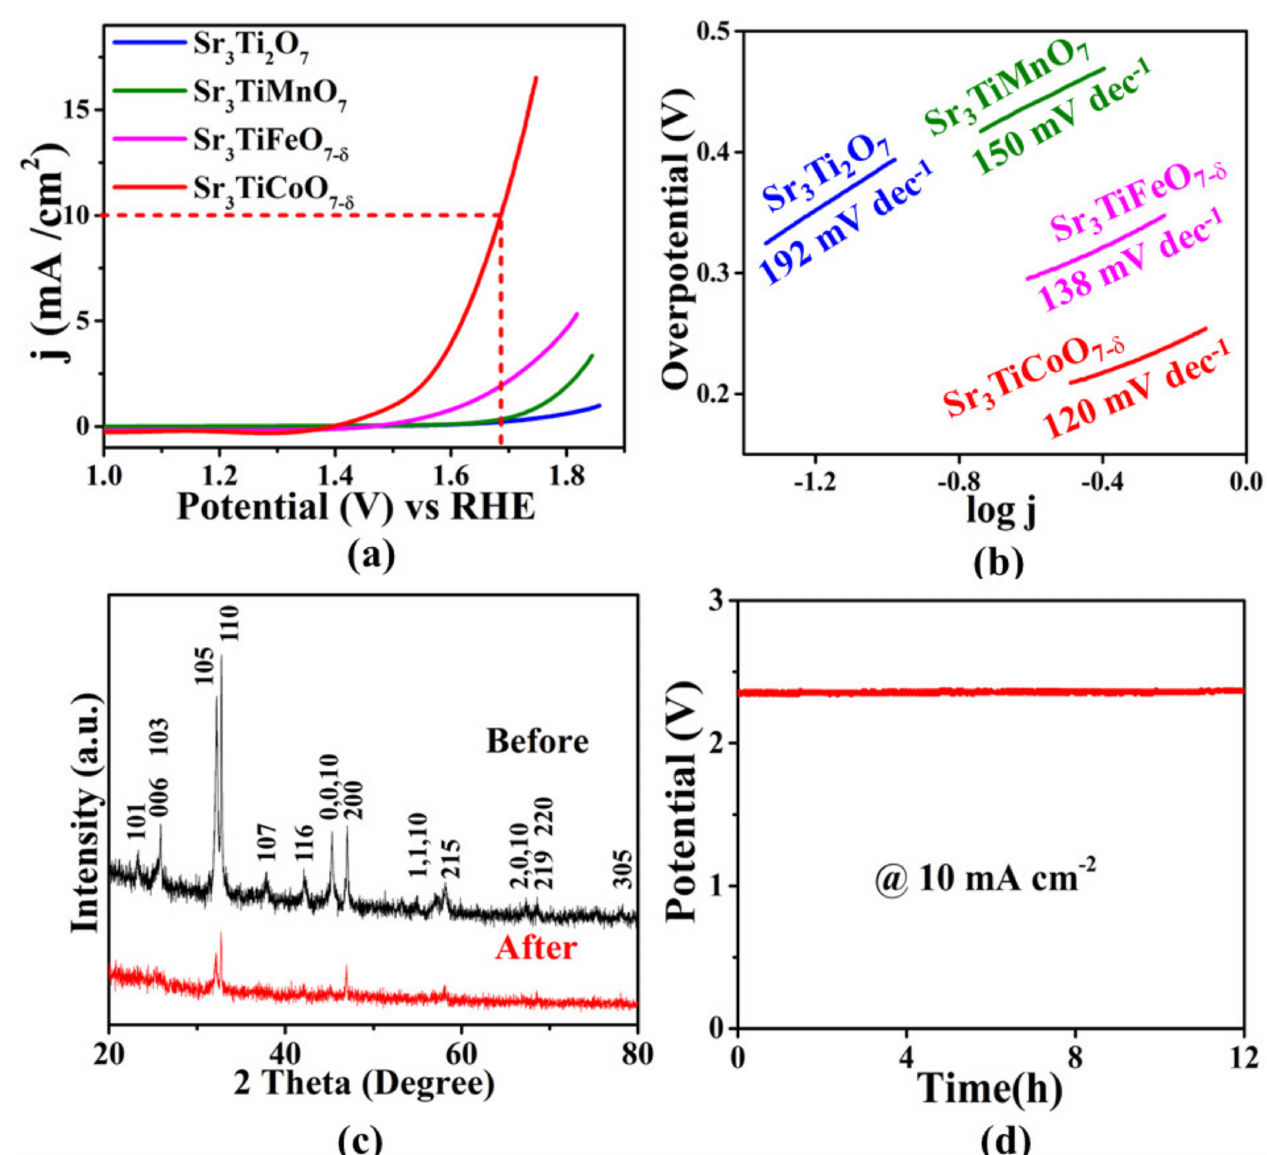
Figure 5. OER activity in 0.1 M KOH ( a ) polarization curves; ( b ) Tafel plots; ( c ) X-ray diffraction data of Sr 3 TiCoO 7 − δ , before and after 100 cycles of OER; ( d ) chronopotentiometry response of Sr 3 TiCoO 7- δ using a two-electrode cell consisting of nickel foam